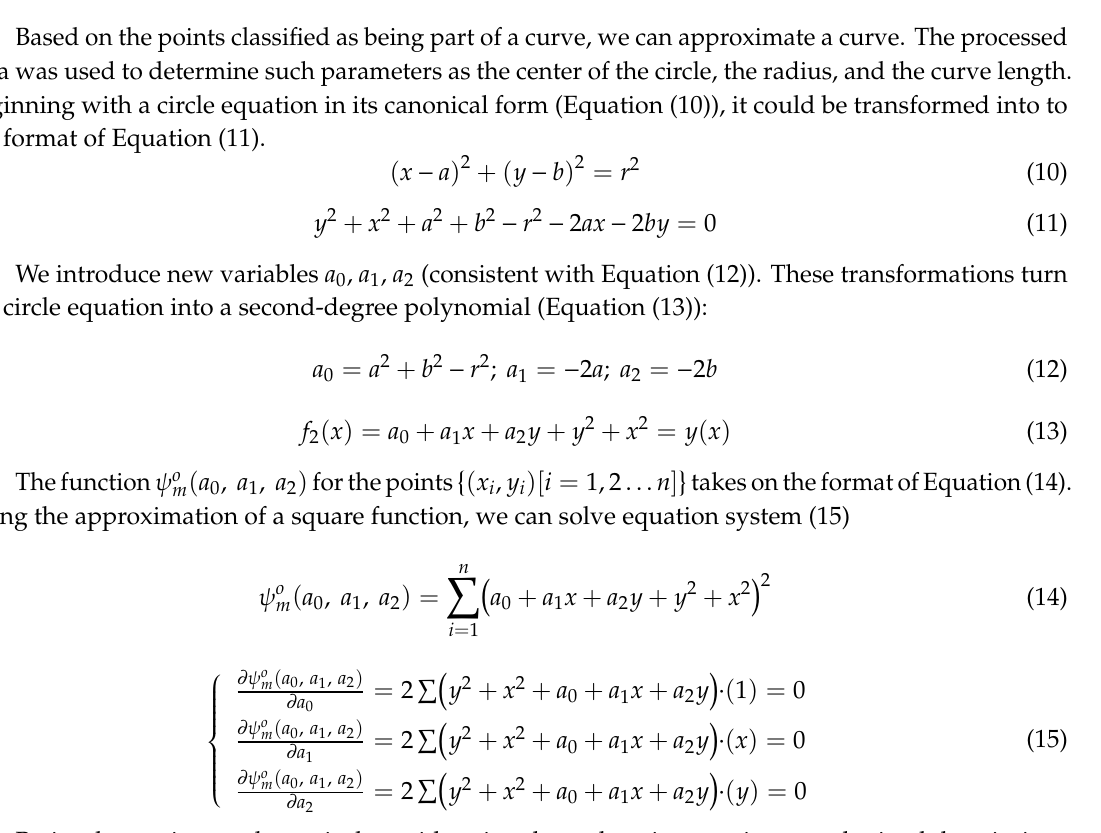
Figure 2. Determining the intersection angle of two straight-line segments of the road, divided by a curve in the horizontal alignment.